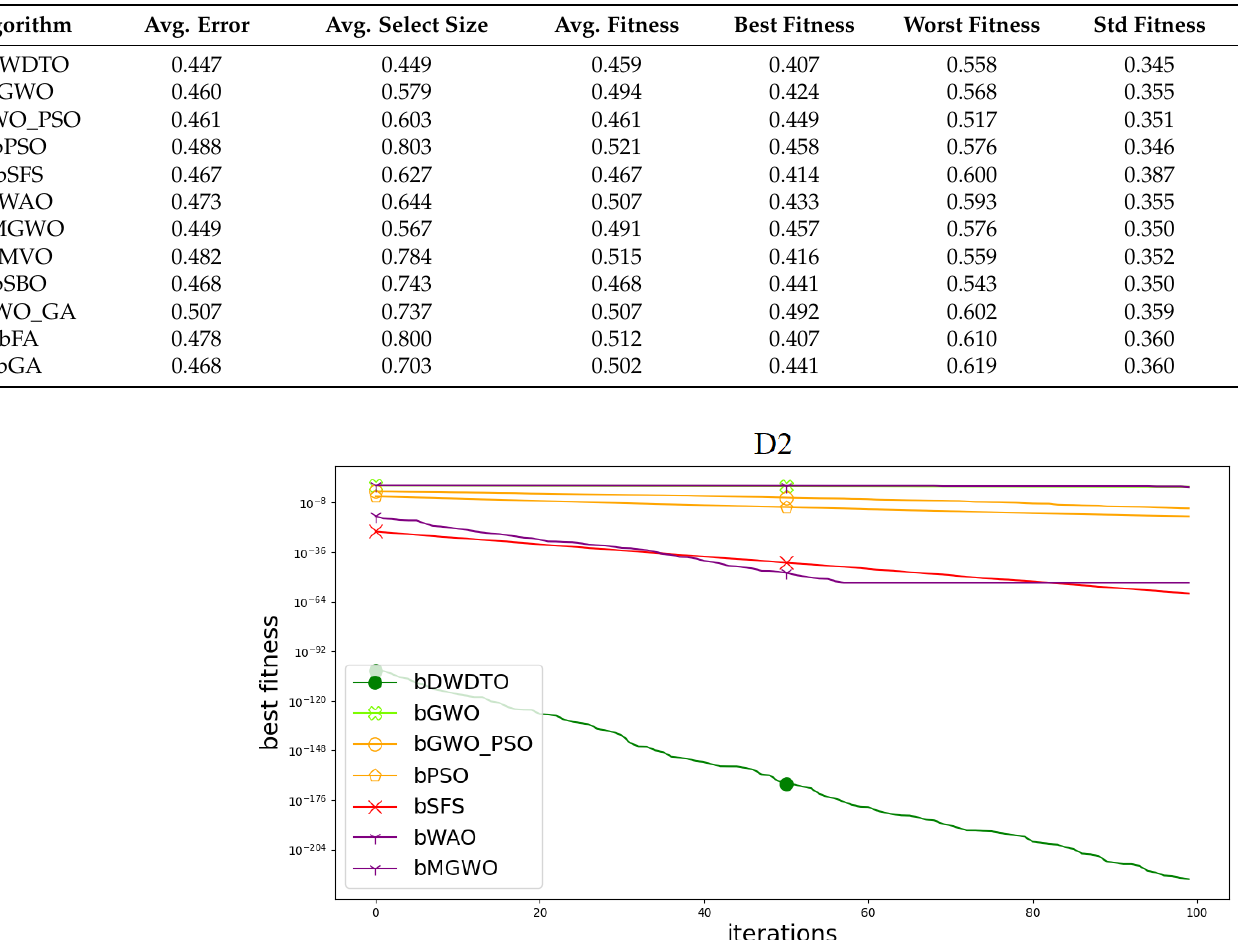
Figure 8. The convergence plot based on the proposed and other competing feature algorithms when applied to the second dataset (D2).